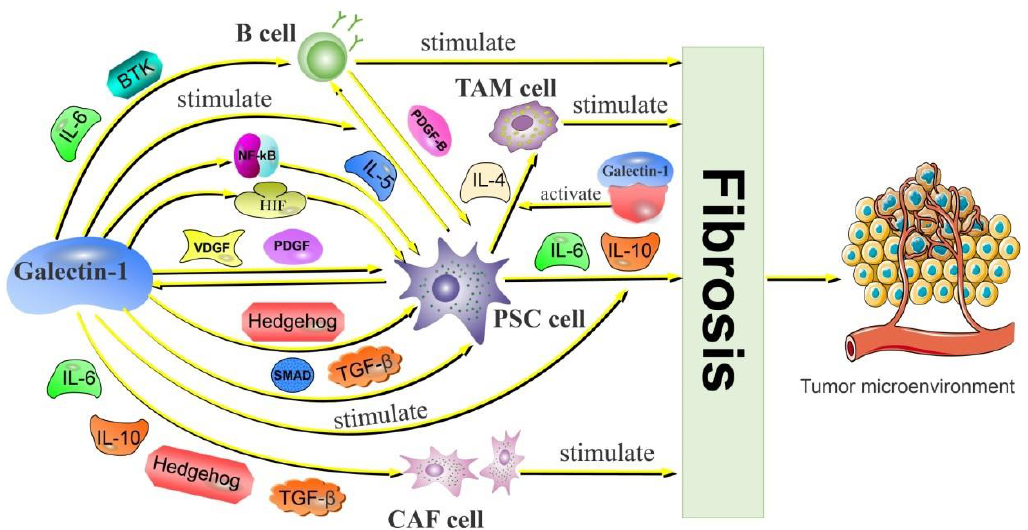
Figure 4. Galectin-1, on the one hand, is involved in the fibrosis induced by CAF cells activated by IL-6,10, HH factors, and TGF- β . On the other hand, galectin-1 activates and recruits PSC cells through HIF, NF- κ B, VEGF, PDGF, HH factor and TGF- β /Smad pathways, and participates in the secretion of pro-fibrotic factor IL-6,10 by PSC, and participates in the fibrosis of PDAC through the above pathways. At the same time, galectin-1 promotes the secretion of IL-5 in the PSC, thereby facilitating B cell recruitment. In addition, galectin-1 directly recruits B cells through the release of IL-6 and BTK, and then participates in B-cell-mediated fibrosis. TAM cells are activated by IL-4 se- creted by PSC and play a role in promoting fibrosis, while galectin-1 enhances the effect of IL-4 by binding to CR3, leading to further enhancement of TAM cell function. (This figure was created by ourselves).